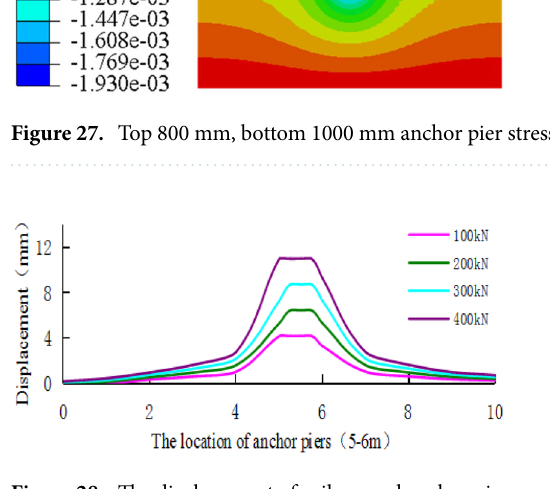
Figure 28. The displacement of soil around anchor pier.